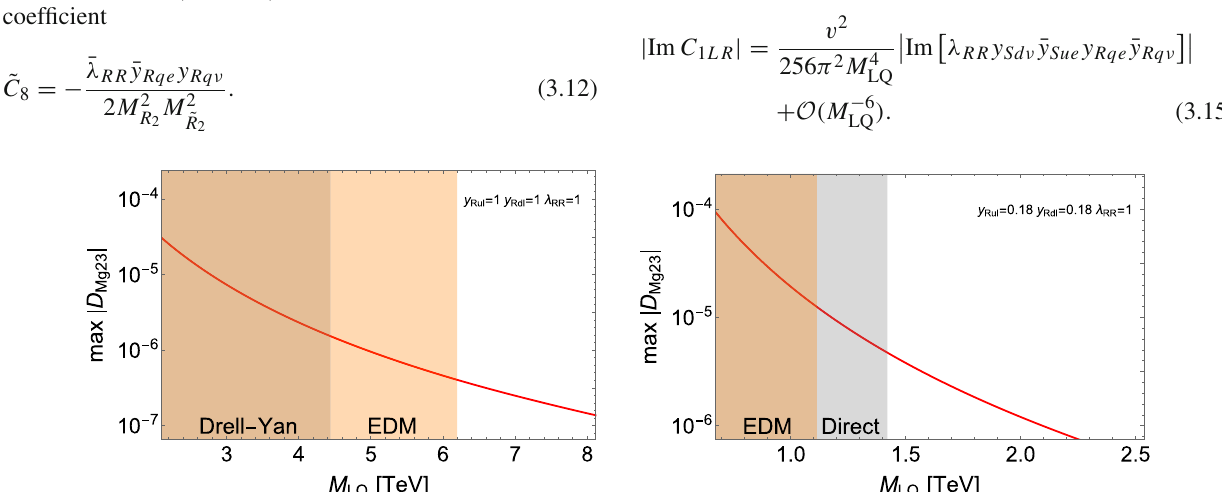
at least ∼ 6 TeV, which translates into a strong suppression of the D parameter to the level below 4 × 10 − 7 . Right: For y Rul = y Rdl = 0 . 18 we show the constraints from pair production at the LHC (direct) which dominate over the Drell–Yan (not shown) and EDM constraints. This is a more favorable situation from the point of view of the D parameter, allowing for | D | ≈ 5 × 10 −